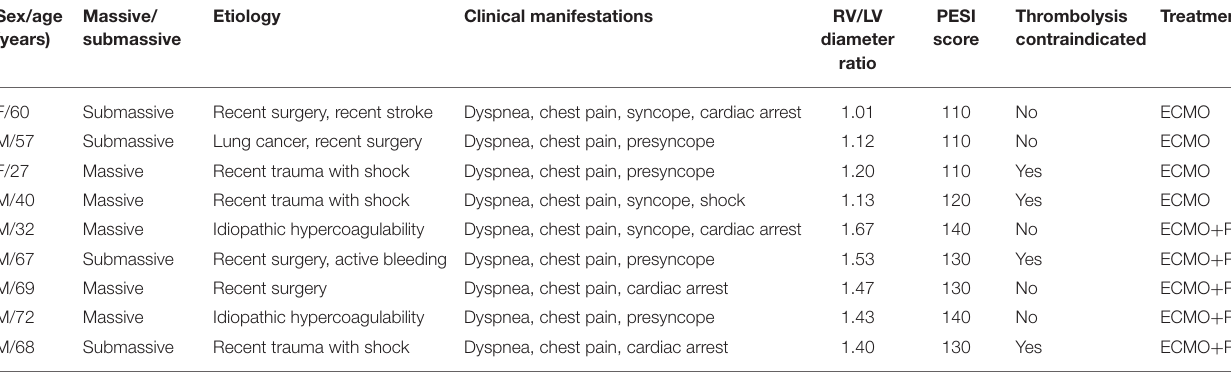
TABLE 3 | Characteristics of each patient treated with VA-ECMO with or without AngioJet percutaneous rheolytic thrombectomy. Sex/age (years)